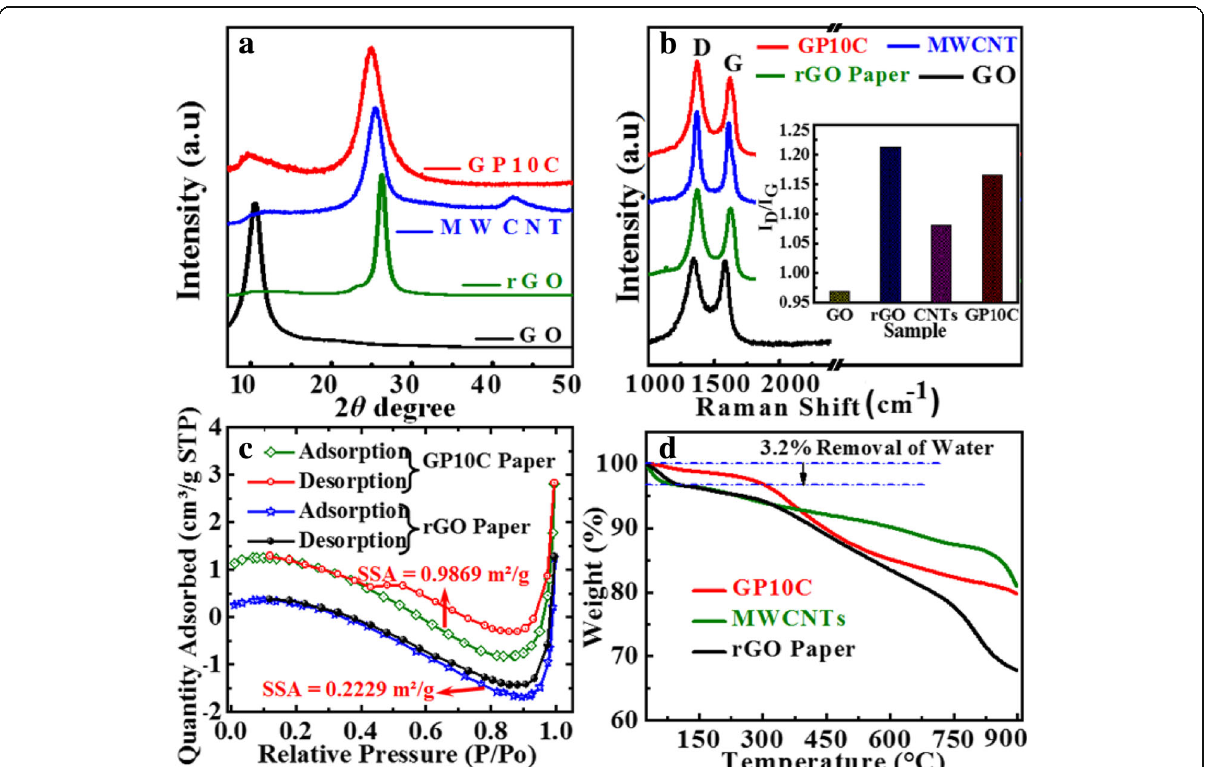
Fig. 3 XRD patterns of GO, rGO paper, MWCNTs, and GP10C film. a , b Raman spectra evolution of D and G bands, c BET analyses of rGO, rGO/ CNT films, and d TGA curves of rGO film, MWCNT, and GP10C